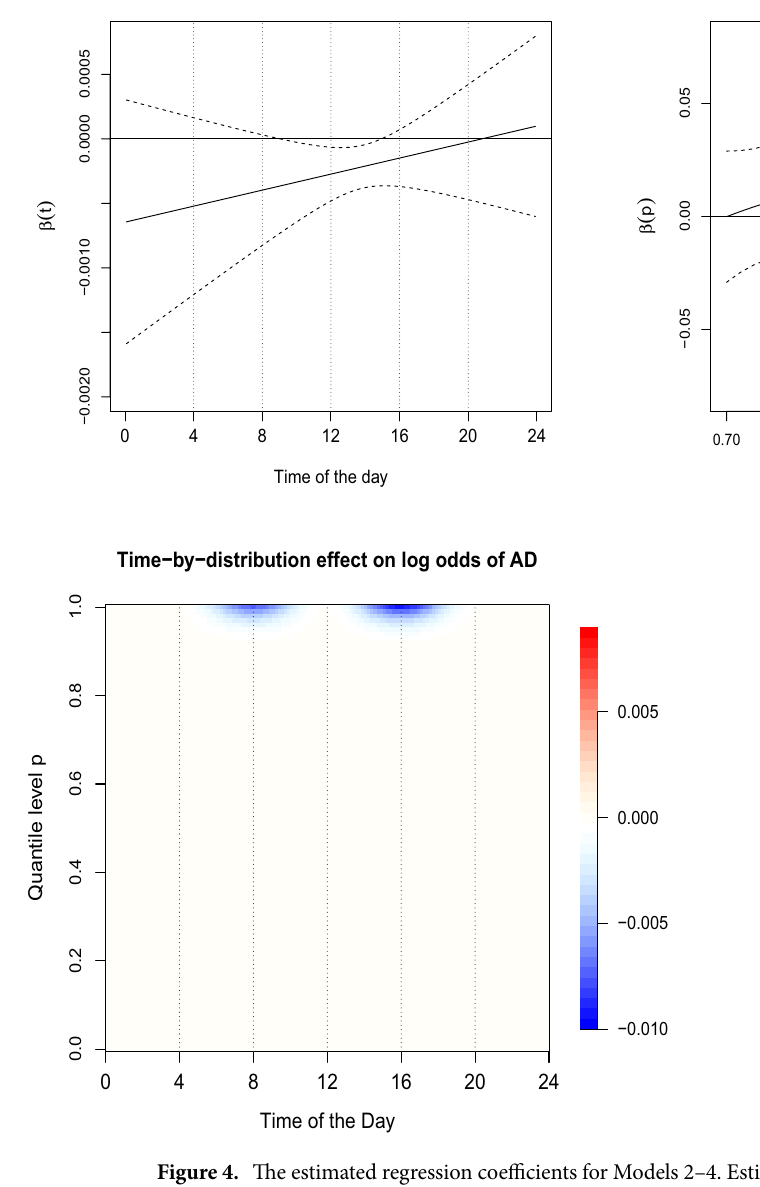
( 0.7, 1 ) ). Estimated bivariate effect ∈